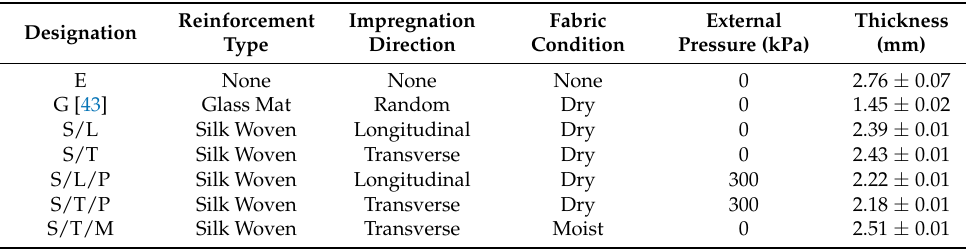
Table 1. Laminate designations, reinforcement types, and fabric/lay-up details. The external pressure is given in gauge